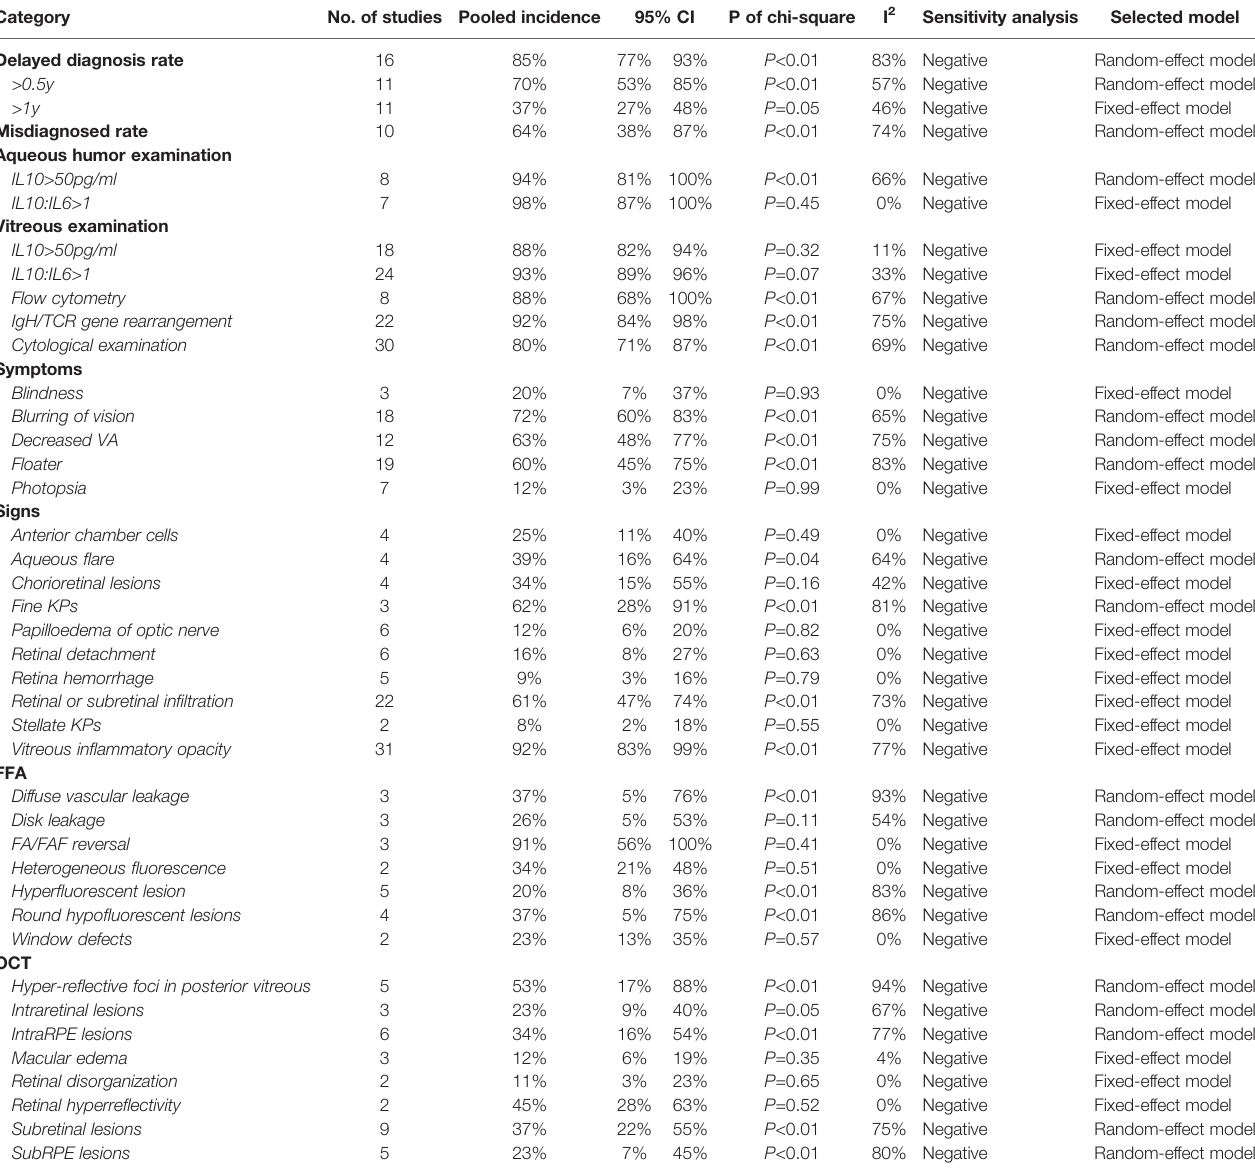
TABLE 3 | Pooling results about the diagnostic features and techniques of PIOL.